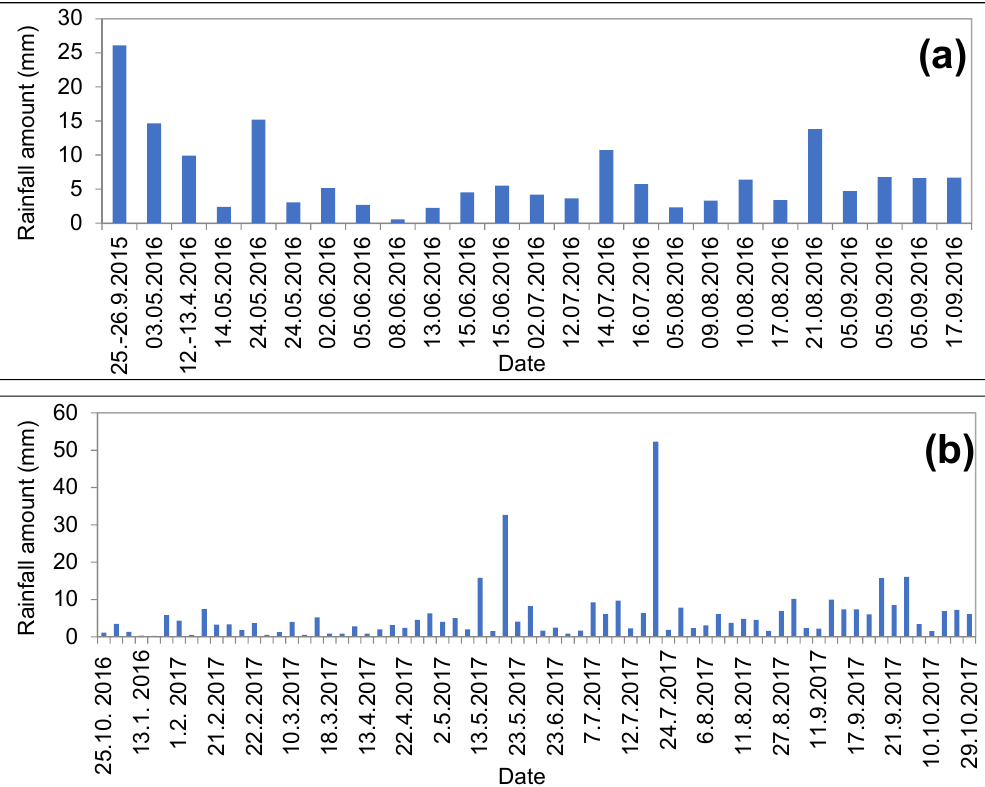
Figure 5. Total rainfall amounts and date of occurrence of selected rainfall events during the two time periods: ( a ) September 2015–October 2016; ( b ) October 2016–October 2017.